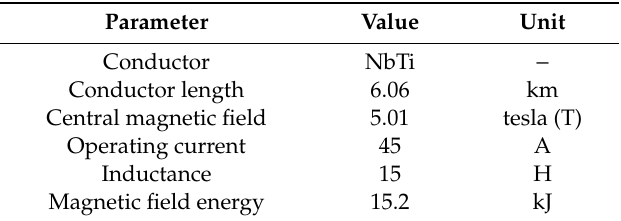
Table 1. Specifications of the low temperature superconducting magnet.